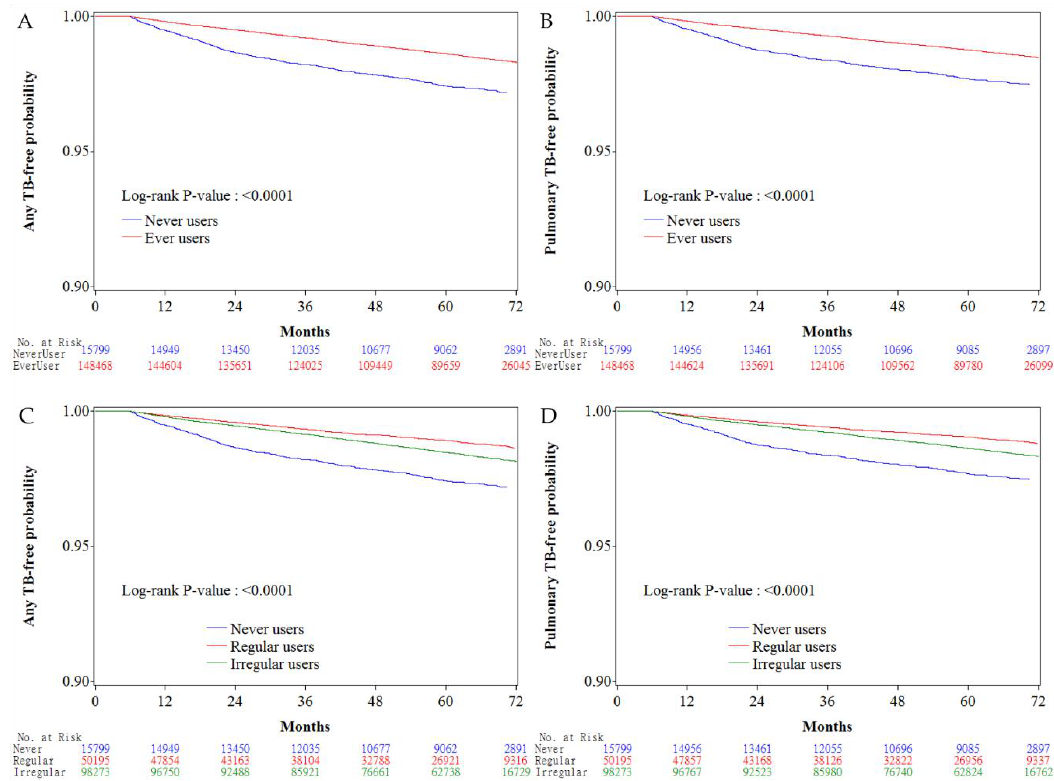
Figure 2. Kaplan–Meier curves comparing tuberculosis (TB) infection-free probability with regards to metformin exposure. ( A ) any TB-free probability in never users and ever users, ( B ) pulmonary TB-free probability in never users and ever users, ( C ) any TB-free probability in never users, irregular users, and regular users, ( D ) pulmonary TB infection-free probability in never users, irregular users, and regular users (TB: tuberculosis